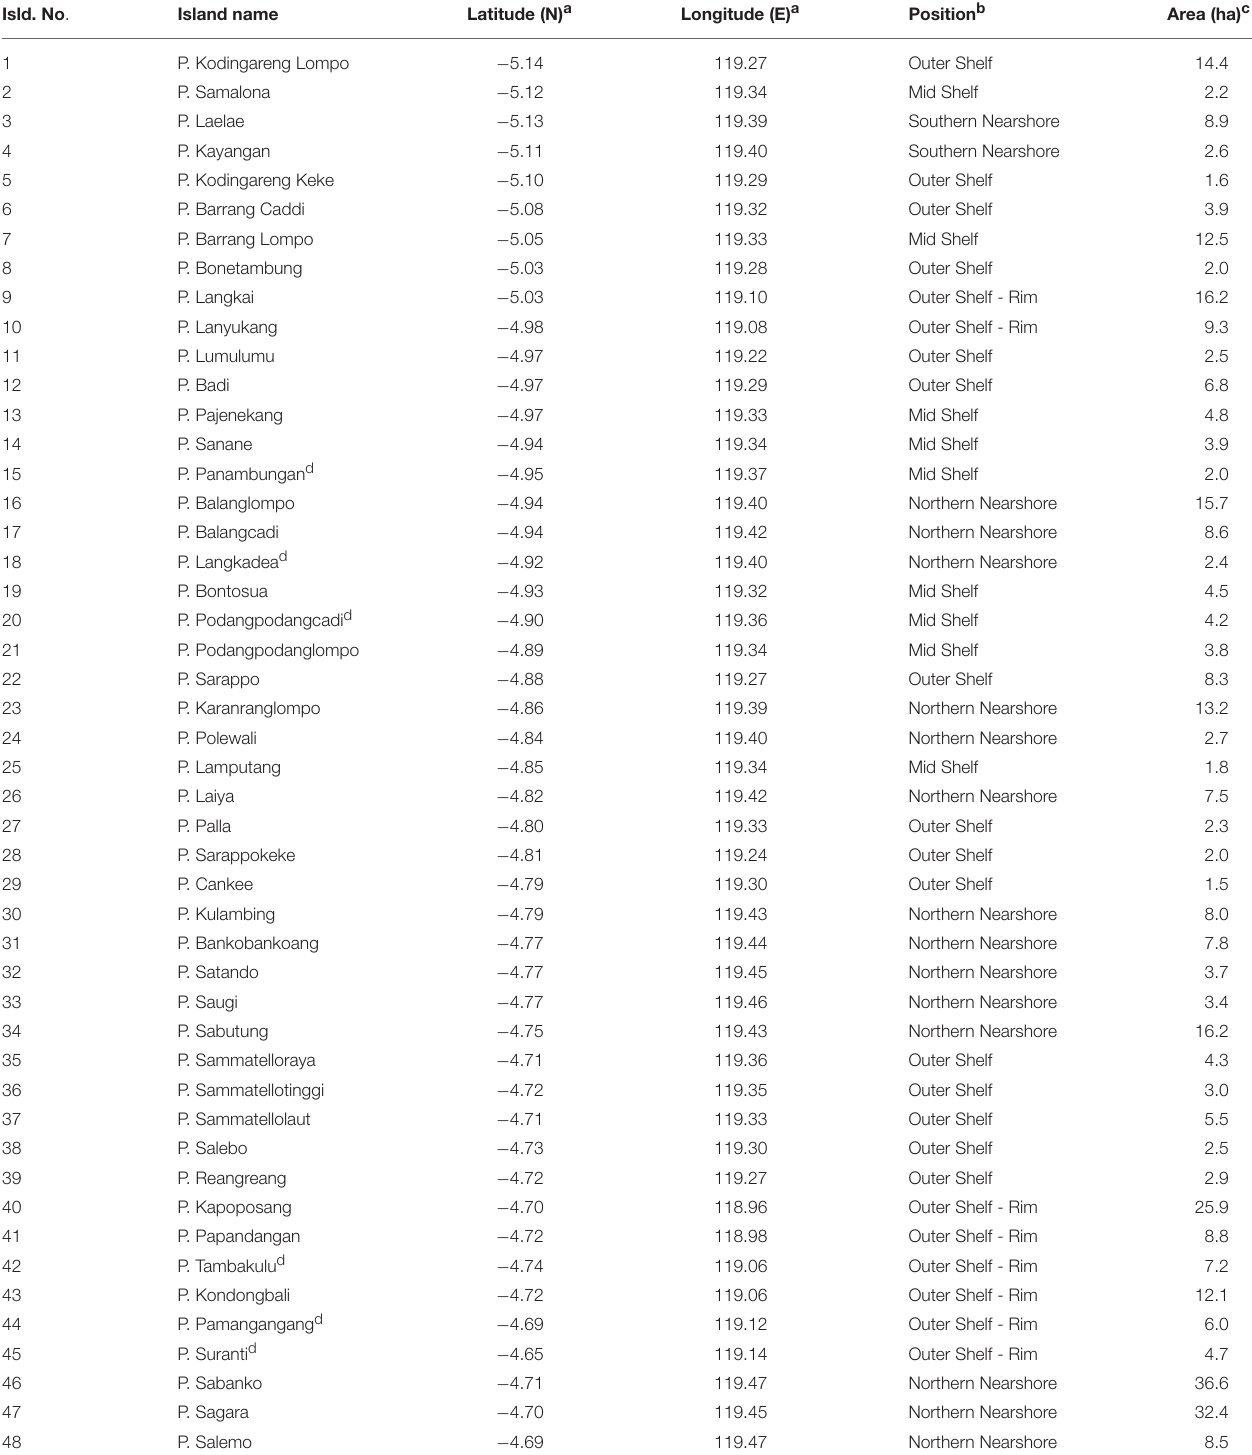
TABLE 1 | Summary of location and area of major vegetated islands of the Spermonde Archipelago. Isld. No